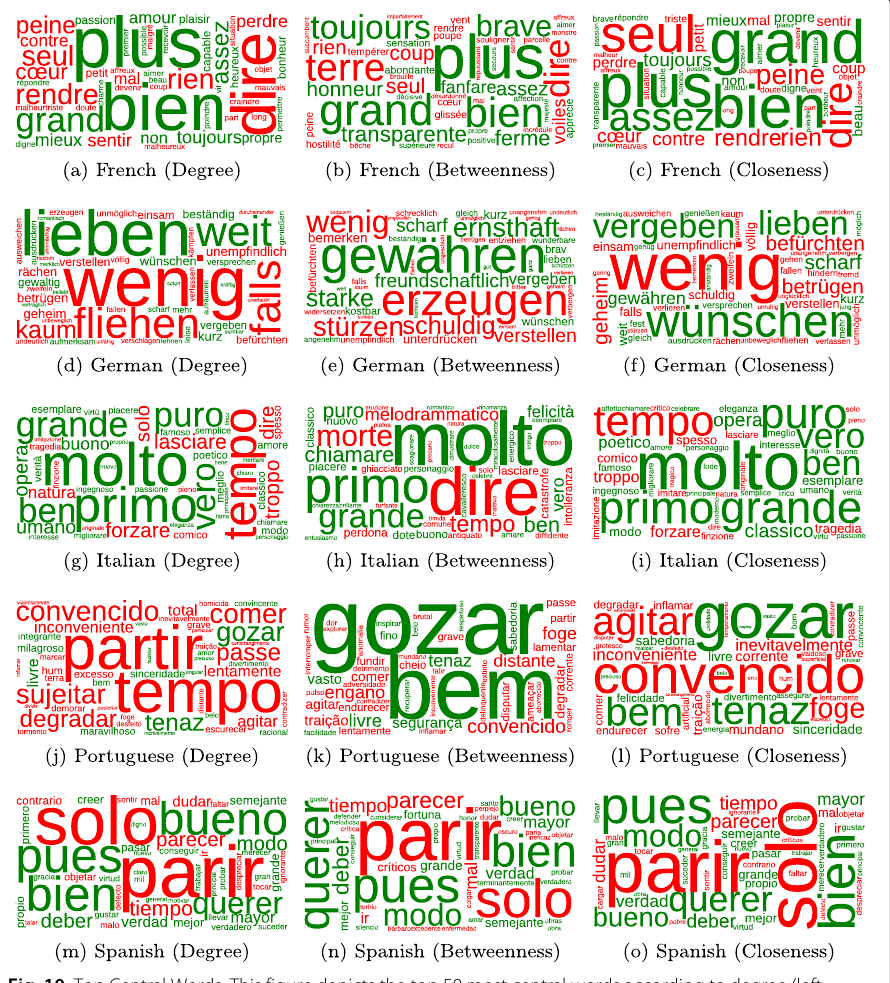
Fig. 10 Top Central Words. This figure depicts the top 50 most central words according to degree (left column), betweenness (center column) and closeness (right column) centrality, respectively for French, German, Italian, Portuguese and Spanish (top to bottom rows). The majority of top central words convey a positive sentiment for Italian and Spanish and a negative sentiment for French, German and Portuguese across all centrality metrics. Note that words stem from the languages of the 18 th century and respective European countries and, thus, do not relate to potentially ambiguous meanings of modern day languages